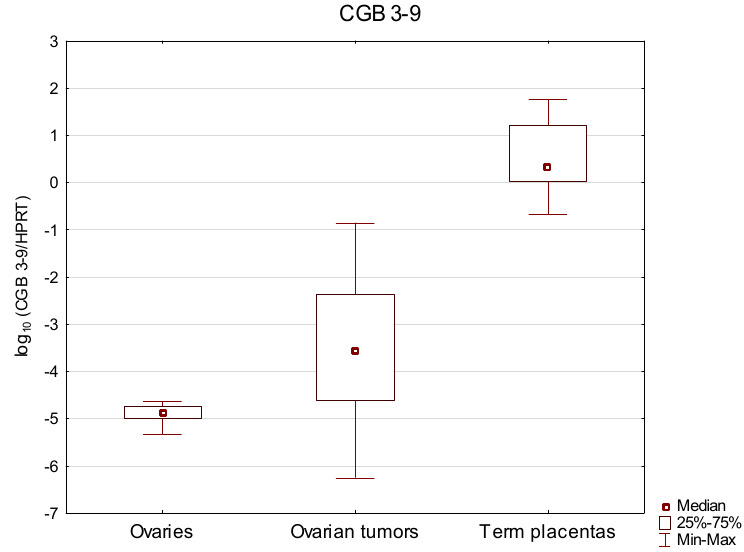
Figure 2. Relative expression of CGB3-9 genes in normal ovarian tissues, ovarian carcinomas and term placentas. Results are presented as the logarithm to the base